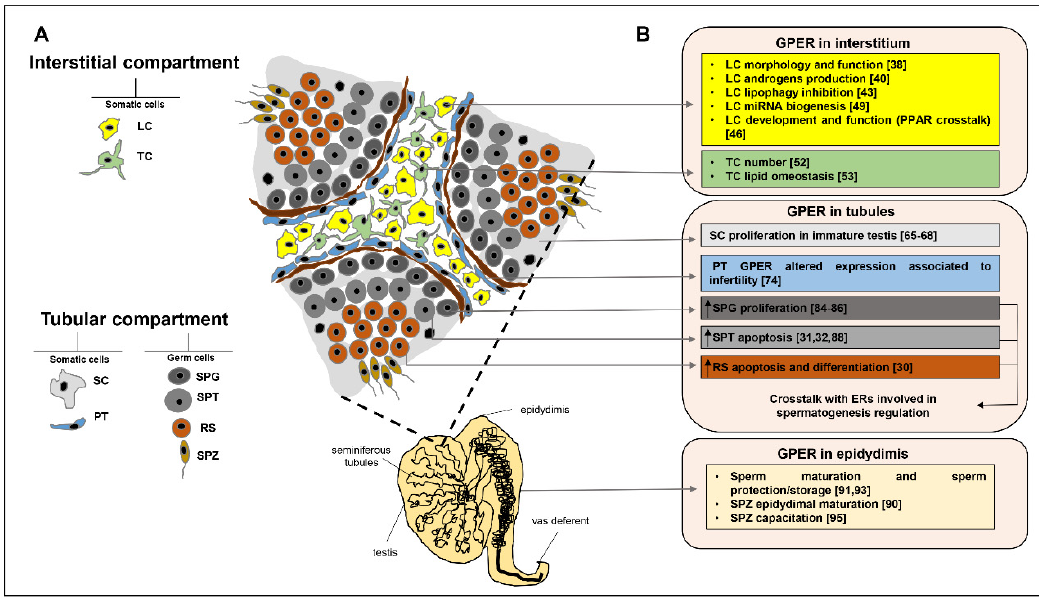
Figure 1. GPER role in testicular interstitial and tubular compartment and in epididymis. In this figure are summarized the knowledge of GPER role ( B ) in testicular interstitial and tubular compartments ( A ) and in epididymis. The drawing represents a cross section of seminiferous tubules, surrounding interstitium and several testicular cell types ( A ). LC: Leydig cells; TC: telocytes; SC: Sertoli cells; PT: peritubular cells; SPG: spermatogonia; SPT: spermatocytes; RS: round spermatids; SPZ: spermatozoa.